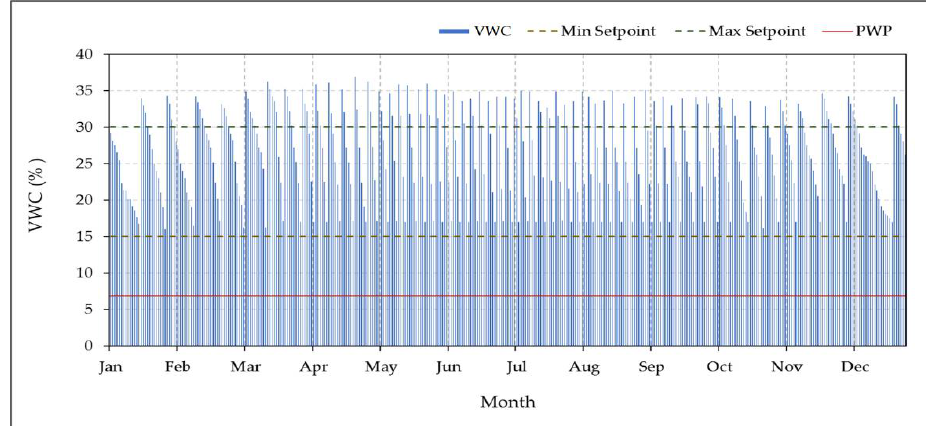
Figure 12. The measured volumetric water content of the controlled subsurface irrigation system soil with sensor-based irrigation method of over the year 2020 in the experimental site. The VWC was controlled between the Min Setpoint (15%) and the Max Setpoint (30%). PWP is the permanent welting point of the soil in the experimental site.